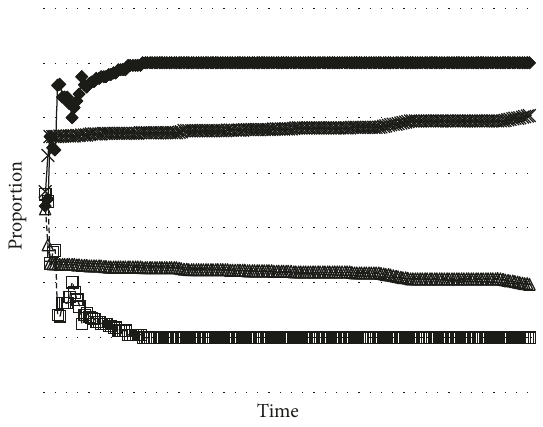
Figure 11: The comparison of producers’ strategy variation under the condition of consumers’ unilateral monitoring and collaborative